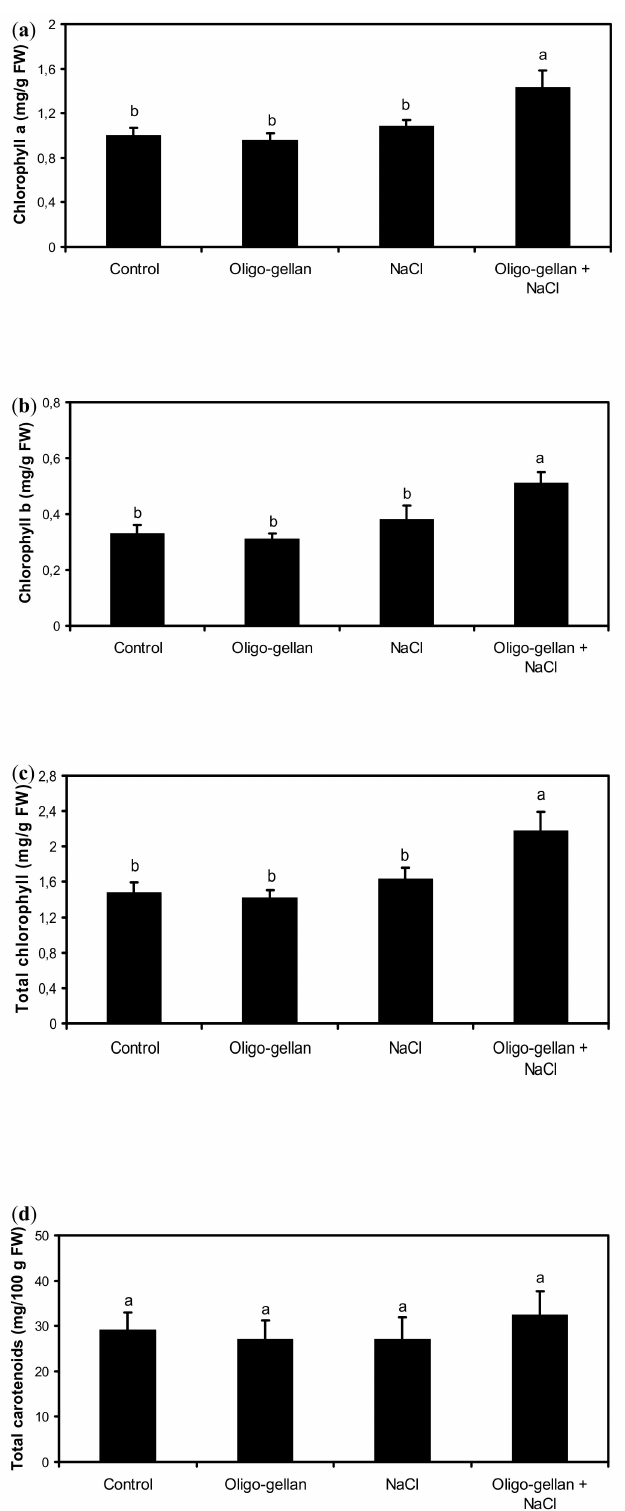
Figure 1. E ff ects of oligo-gellan pretreatment (100 ppm) and salt stress (100 mM NaCl) on concentrations of chlorophyll a ( a ); chlorophyll b ( b ); total chlorophyll ( c ); and total carotenoids ( d ) in red perilla plants. Bars represent the means of three biological replicates ± standard deviations. Di ff erent letters indicate statistical di ff erences at p ≤ 0.05 (Tukey’s